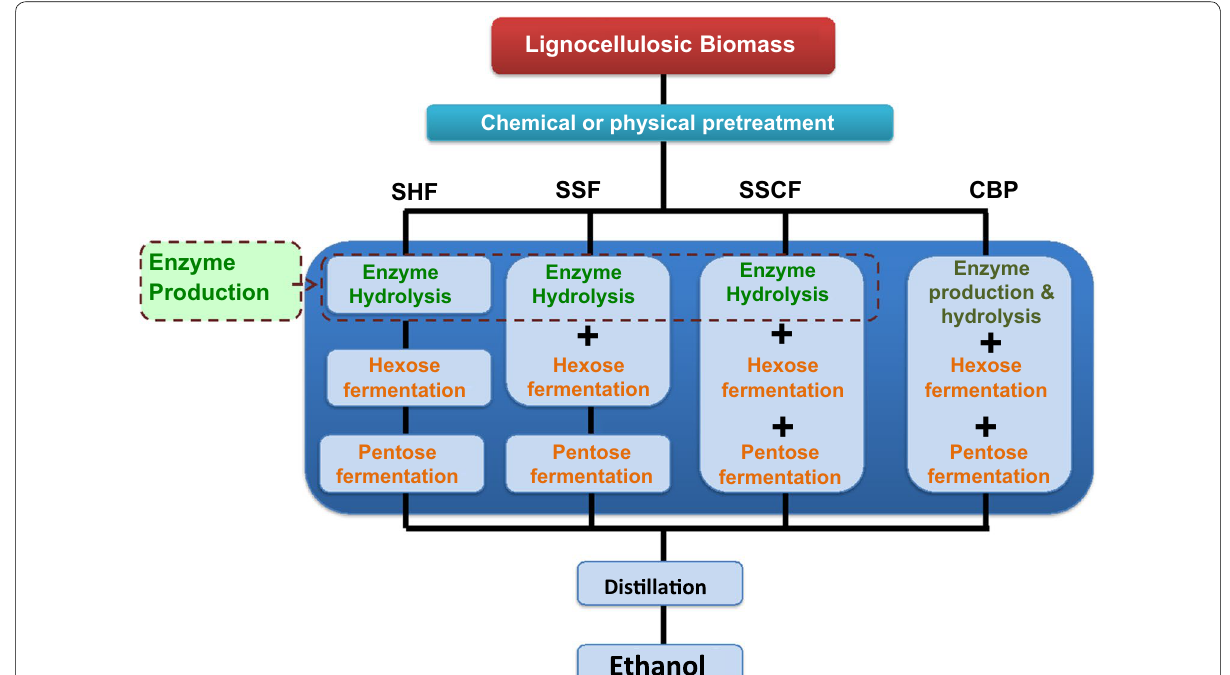
Fig. 1 The steps involved in the bioprocessing to lignocellulose to ethanol. Following chemical pretreatment to break down the tough, recalcitrant material in lignocellulosic biomass, it is more susceptible to enzymatic attack because of the exposure of the underlying carbohydrates (i.e., cellu- lose and hemicelluloses). Thereafter, there are four possible routes to ethanol production; SHF separate hydrolysis and fermentation, SSF simultane- ous saccharification and fermentation, SSCF simultaneous saccharification and co-fermentation, CBP consolidated bioprocessing. Microbial enzymes produced by bacteria, fungi and other micro-organisms are used to convert the exposed cellulose and hemicellulose sugar polymers to simple sugars which can then be efficiently fermented; in all cases except CBP, these enzymes need to be added (the CBP organism(s) both saccharify and ferment the substrate). Microbial fermentation is the final phase in the bioconversion process. By this stage, the hydrolysate contains a mixture of hexose and pentose sugars such as glucose, xylose, mannose, fructose, galactose and arabinose, which are all fermentable by micro-organisms to produce